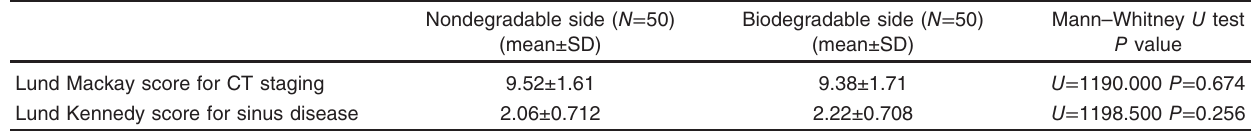
Table 1 Comparison between nondegradable and biodegradable sides regarding the Lund Mackay score for computed tomography staging; Lund Kennedy score for sinus